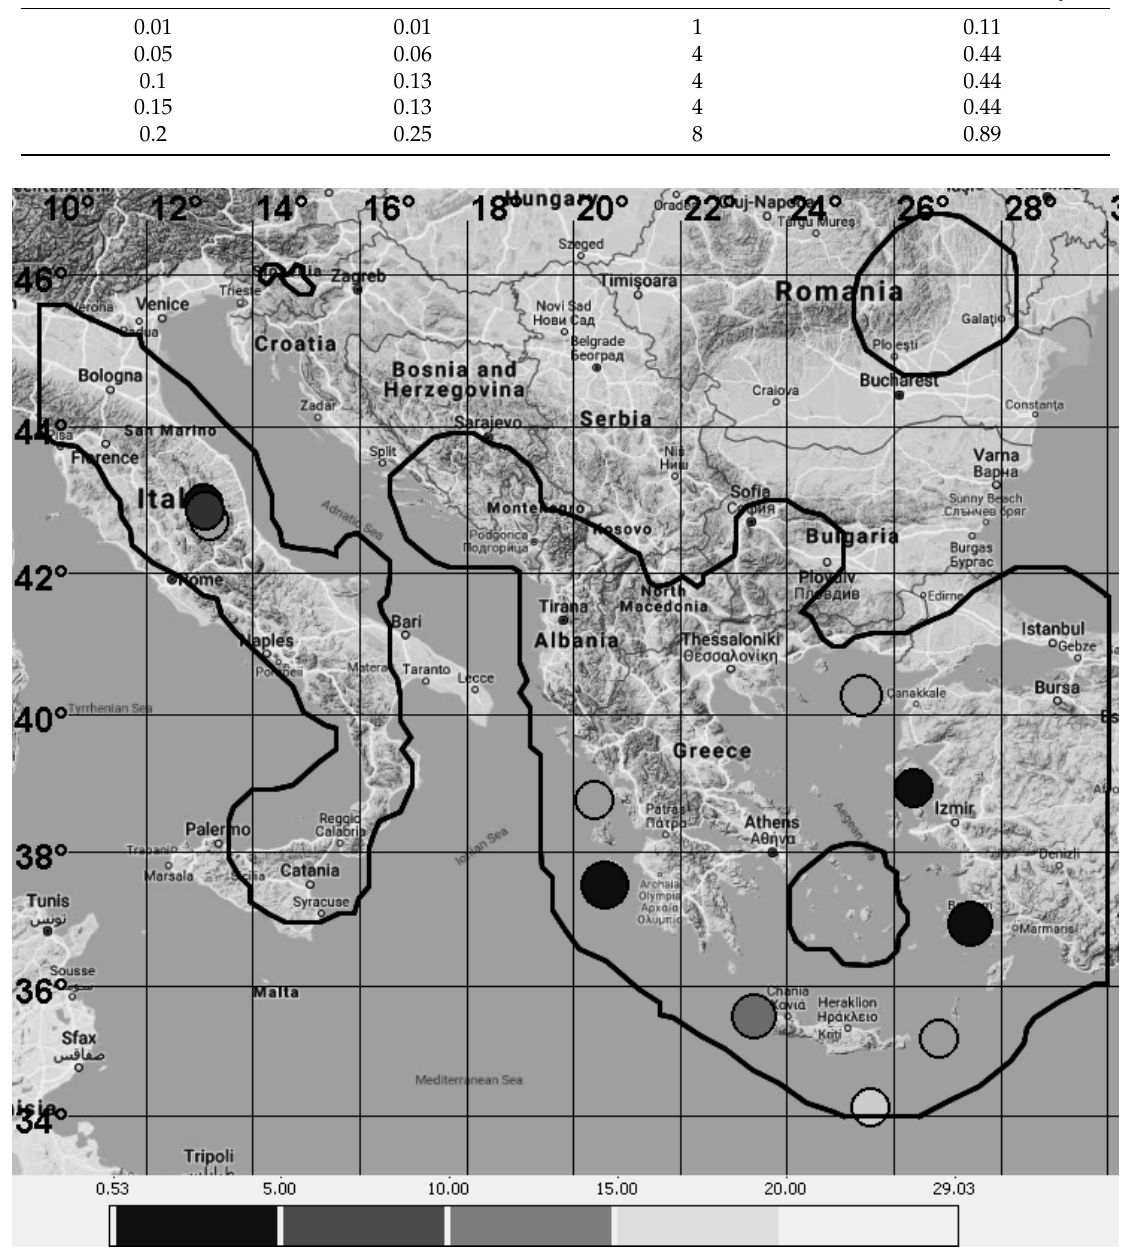
Figure 3. Area of analysis (marked with thick black line) and tested target epicenters of earthquakes in 2009–2018 in the Mediterranean region. Shades of grey indicates the minimum volume of alarm with which the epicenter was forecasted. Darkness of grey decreases in accordance with the volume of the alarm: 0.05, 0.1, 0.15, 0.2. A white color indicates that an earthquake is not forecasted with an alarm volume of less than